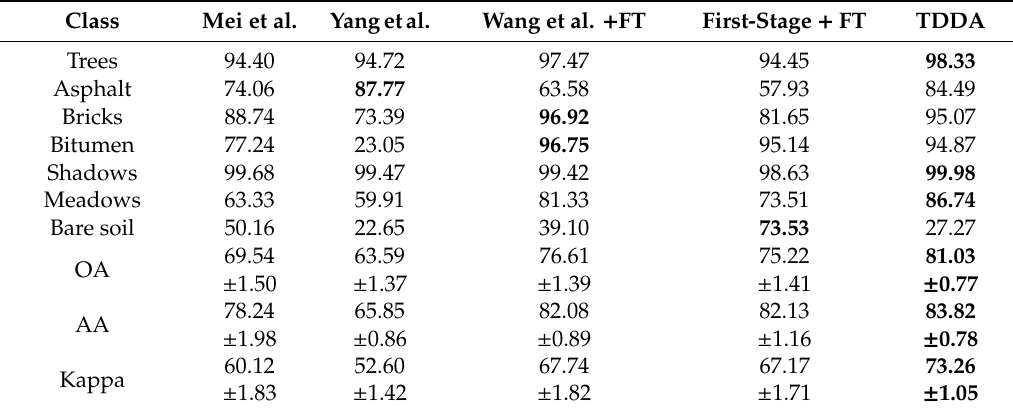
Table 7. Classification accuracy and kappa (%) on Pavia Center → Pavia University dataset.